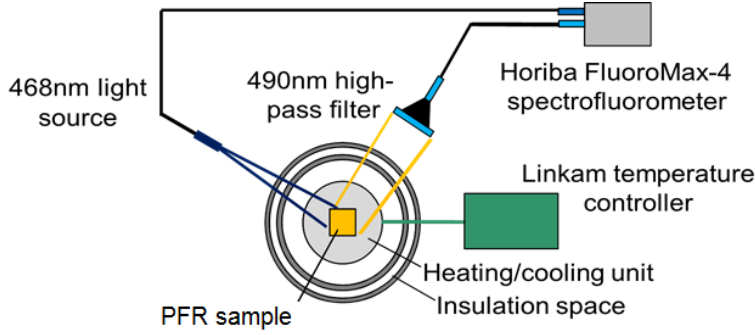
Figure 2. Static response testing setup.